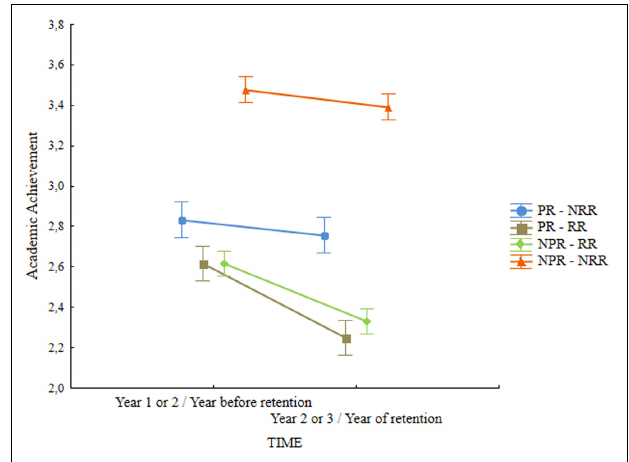
FIGURE 1 | Retention status × time interaction for academic achievement. Vertical bars denote 0,95 confidence intervals. PR – NRR, group with past but no recent retention; PR – RR, group with past and recent retention; NPR – RR, group with no past but recent retention; NPR – NRR, group with no past or recent retention.